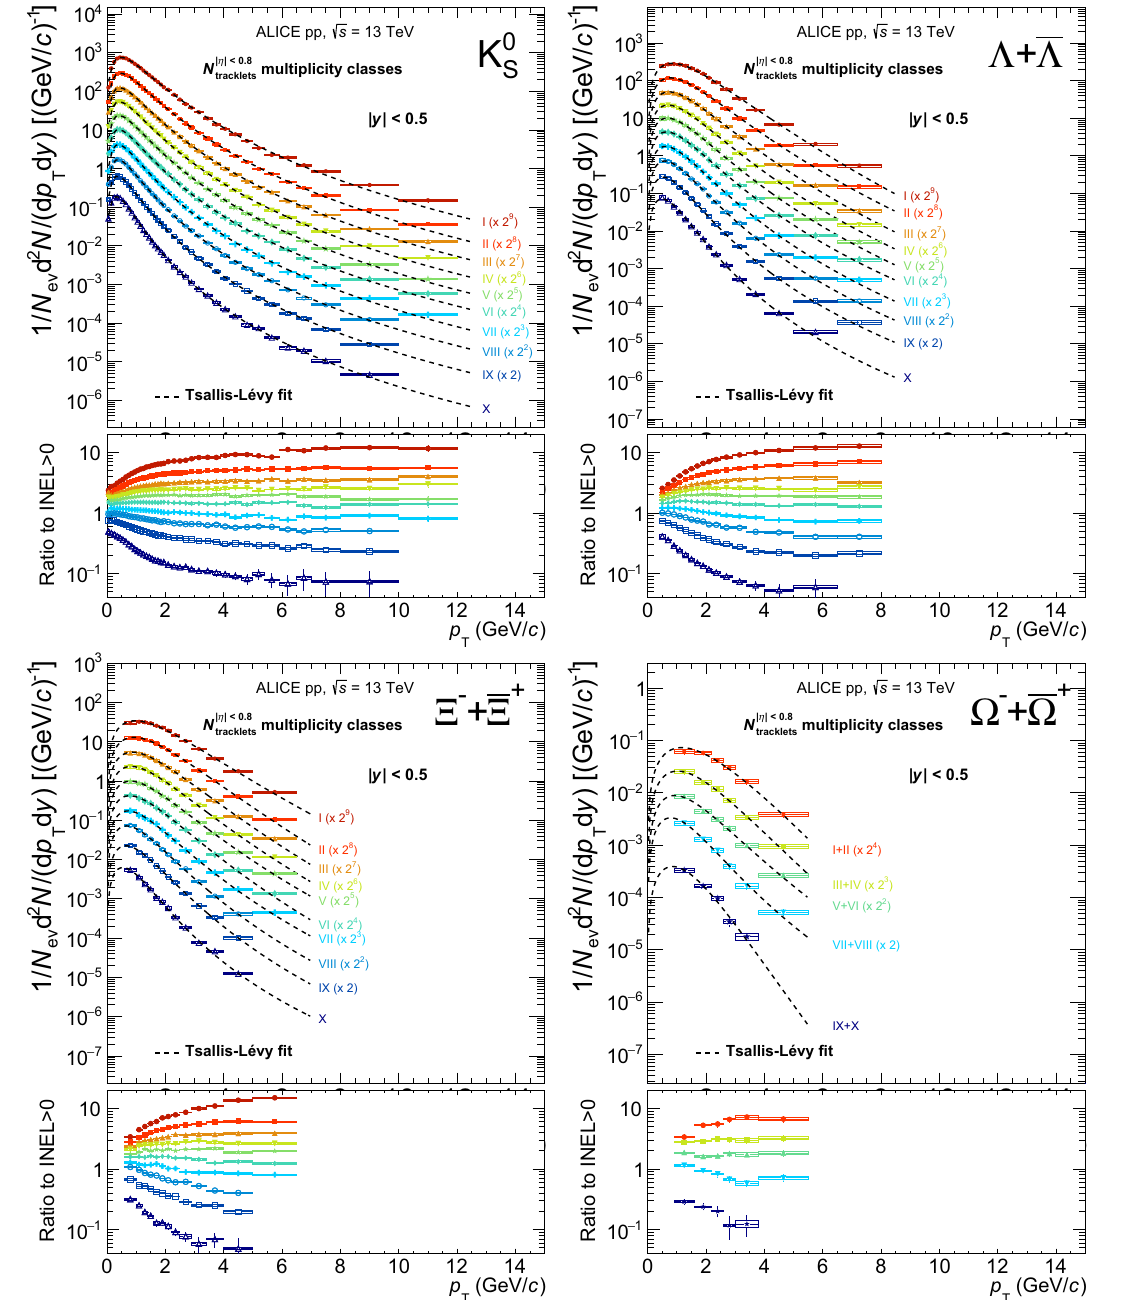
Fig. 3 Transverse momentum distribution of K 0 areobtainedbyconsideringonlycontributionsuncorrelatedacrossmul- , (cid:3) , (cid:4) , and (cid:5) , for S tiplicity. The spectra are scaled by different factors to improve the vis- multiplicity classes selected using the tracklets in | η | < 0 . 8. Statistical ibility. The dashed curves represent Tsallis–Lévy fits to the measured and total systematic uncertainties are shown by error bars and boxes, spectra respectively. In the bottom panels ratios of multiplicity dependent spec- tra to INEL > 0 are shown. The systematic uncertainties on the ratios